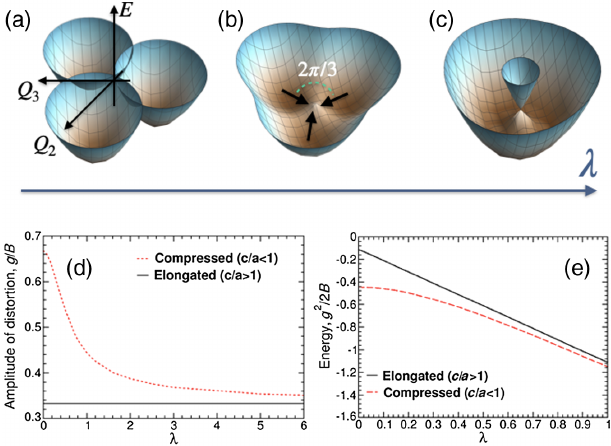
FIG. 2. Results for the t 1 2 configuration ( g ¼ B ¼ 1 ). (a) – (c) g Evolution of the energy surface dependence on Q 2 and Q 3 modes as a function of the spin-orbit coupling constant λ . (d) Amplitude of distortion u as a function of λ at the ð 0 ; (cid:2) u Þ points in the Q 2 Q 3 plane. (e) Energies of compressed and elongated octahedra as function of λ